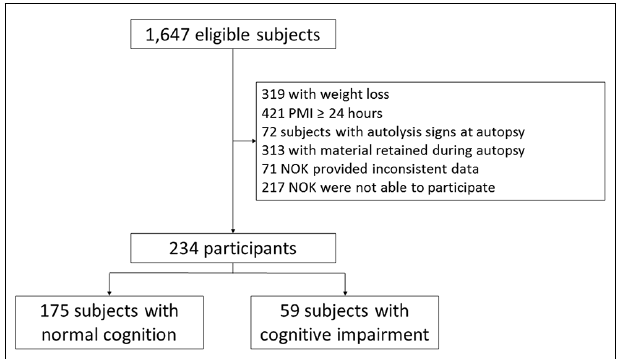
FIGURE 1 | Flowchart of study participants. PMI, post mortem interval; NOK, next of